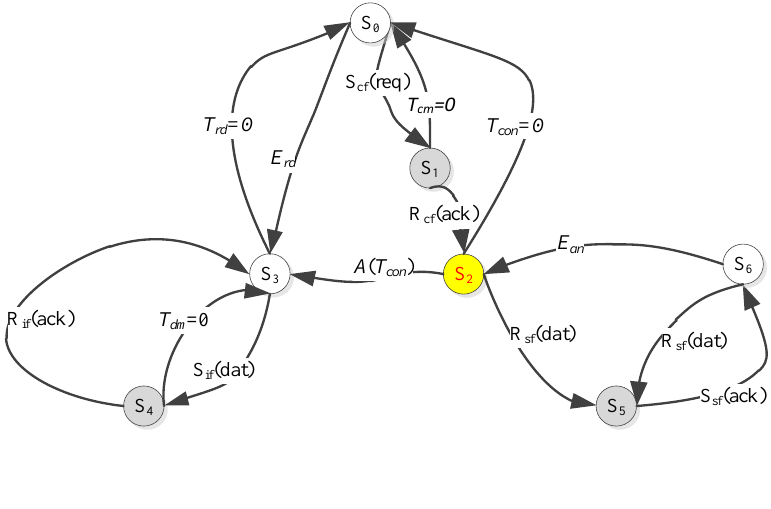
Figure 9. State-transition diagram of station